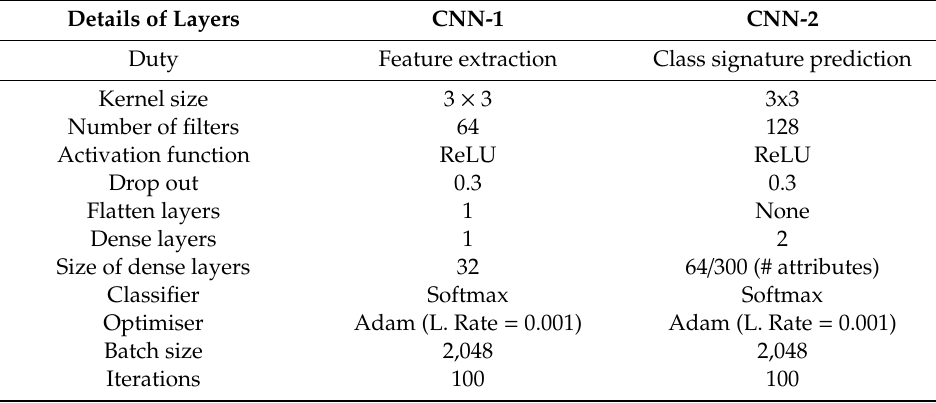
Table 1. Details of the selected CNN-1 and CNN-2